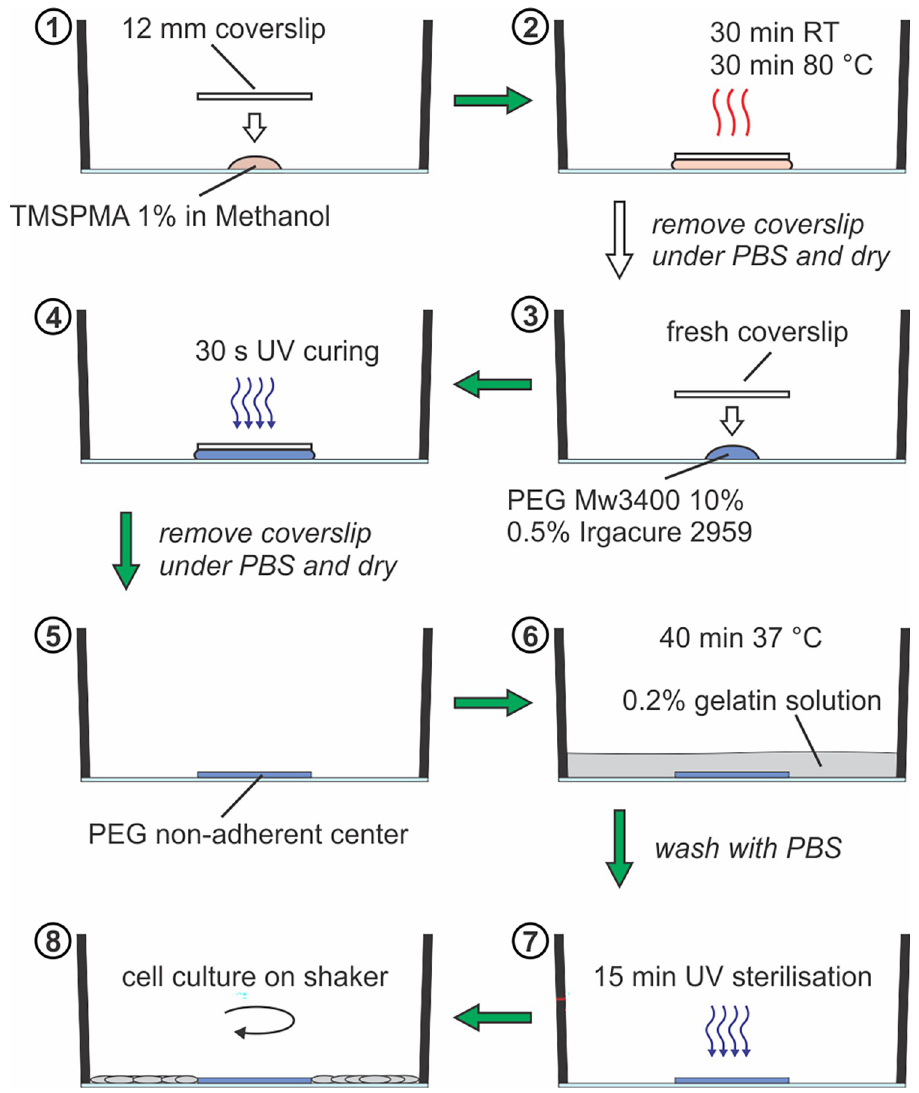
Fig 2. Step-by-step description of the method to block cell adhesion in the center of the well using a PEG- hydrogel. (1) Placing a drop of TMSPMA at the center of the well. (2) Covering the droplet with a glass coverslip for incubation. (3,4) Incubation with PEG Mw3400 and Irgacure 2959 using a fresh coverslip and curing through UV exposure. (5,6) Coating of the well with a 0.2% gelatin solution and washing. (7) Sterilization with UV light. (8) Cell culturing on an orbital